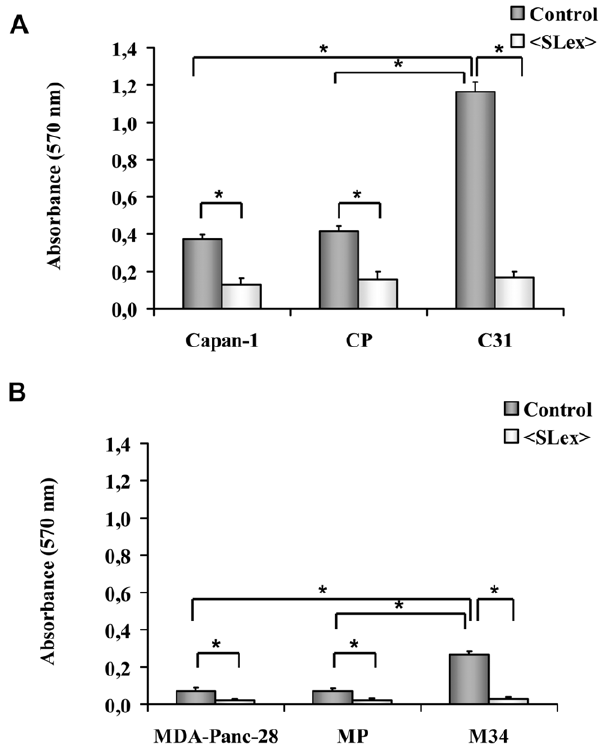
Figure 3. Binding assay to rh-E-selectin. Capan-1 variant cells ( Figure 3A ) and MDAPanc-28 variant cells ( Figure 3B ), previously incubated with PBS-1% BSA (light bars) or anti-SLe x MAb (dark bars), were added to 96-well microplates coated with rh E-selectin or PBS-1% BSA (negative control). Adherent cells were estimated with a MTT-based colorimetric assay. Results are expressed as the Specific binding to E- selectin (O.D. 570 nm of cells bounded to E-selectin – O.D. 570 nm of cells bonded to PBS-1% BSA) versus cells previously incubated or not with anti-SLe x MAb. Data represents the mean 6 SD of 3 separate experiments, each in five replicates (n=15). * Significantly different ( P , 0.001 ).